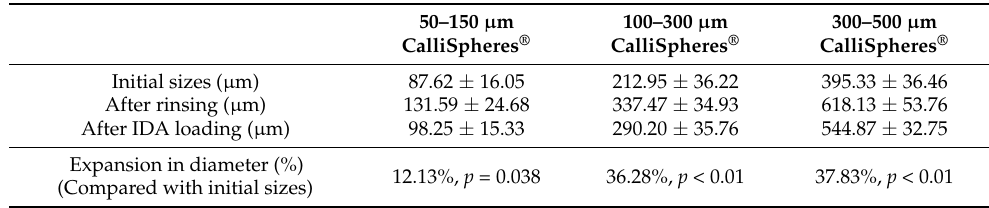
Table 1. Diameter changes in IDA loading process ( n =